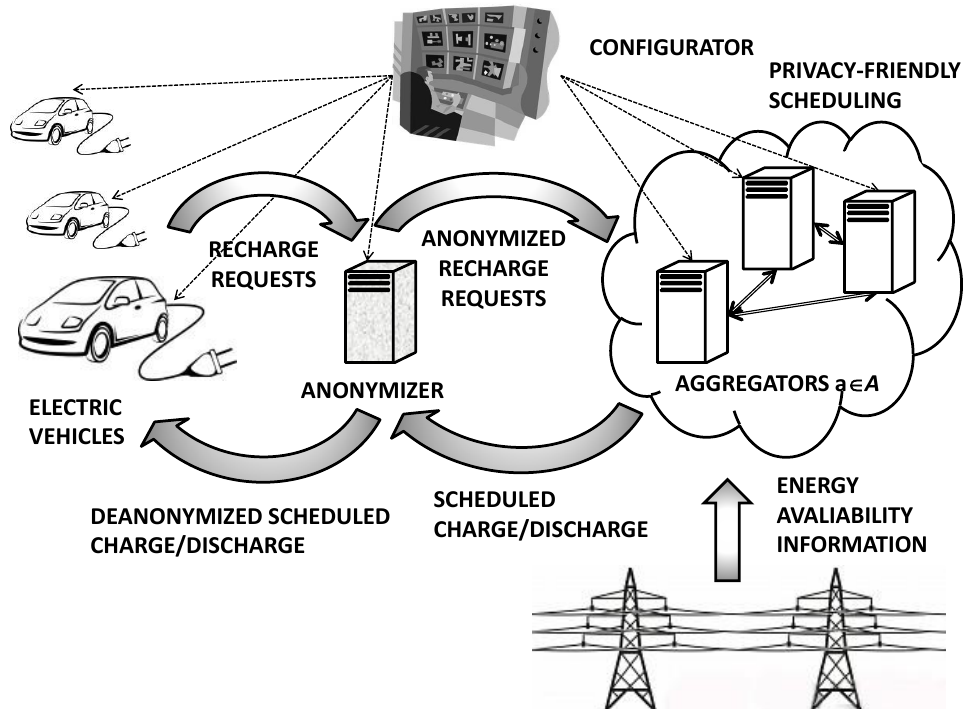
Figure 1. The privacy-friendly scheduling